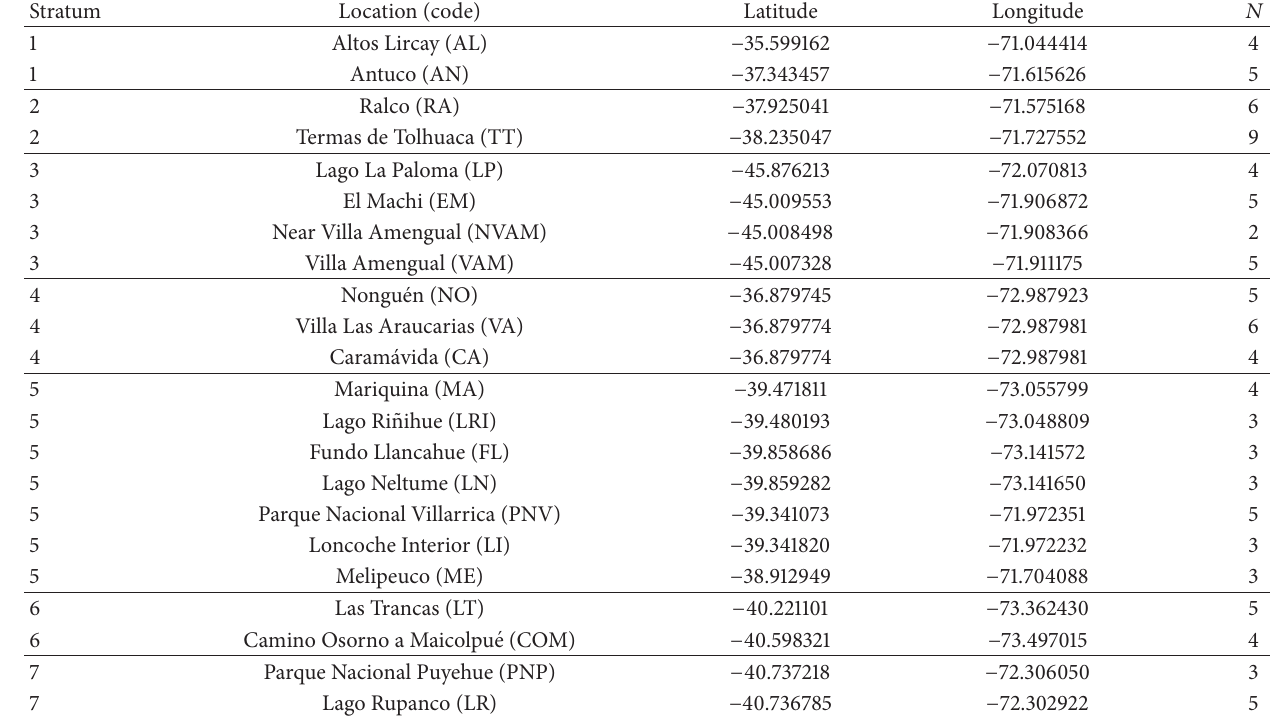
Table 1: Strata code and location, geographical coordinates, and sample size of the sampled individuals of Nothofagus dombeyi in Chile.